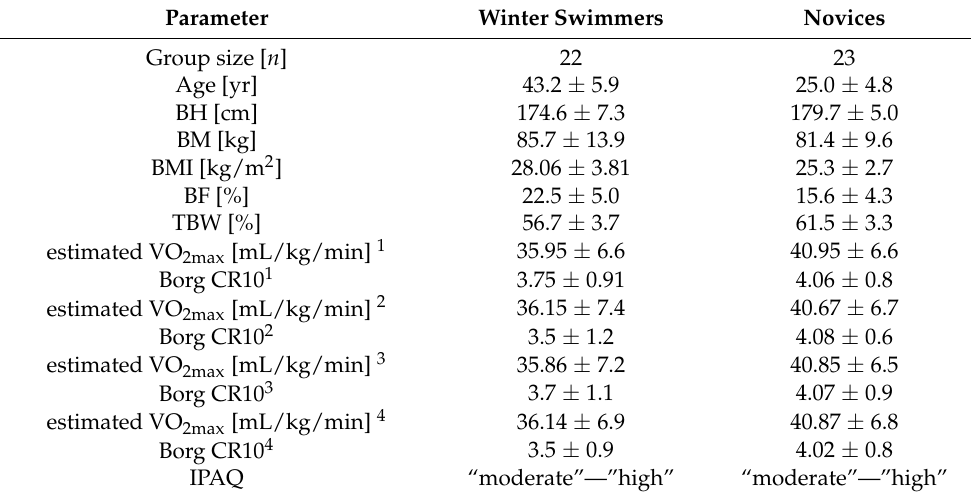
Table 1. Basic characteristics of the study group (data are presented as means ± SD). Parameter Winter Swimmers